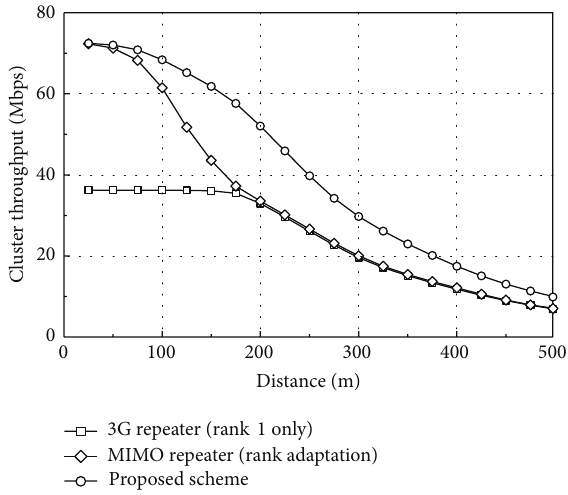
Figure 4: Cluster throughput at different distances. Two UEs are located at the same distance from the BS (or repeater) in each coverage (six UEs per